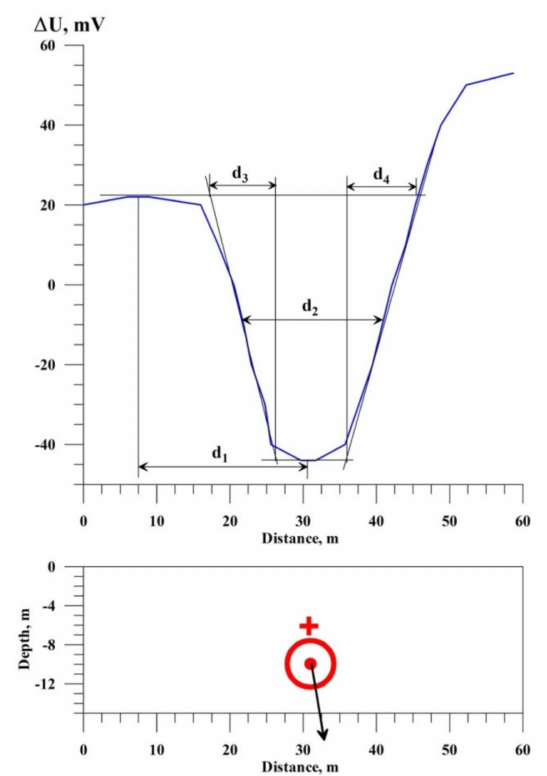
Figure 18. Quantitative analysis of SP anomaly along profile A—B (location of profile is shown in Figure 17). The red cross designates the position of the middle of the thin bed upper edge, the red circle shows the position of the center of the horizontal circular cylinder (HCC). The black arrow shows the orientation of the polarization